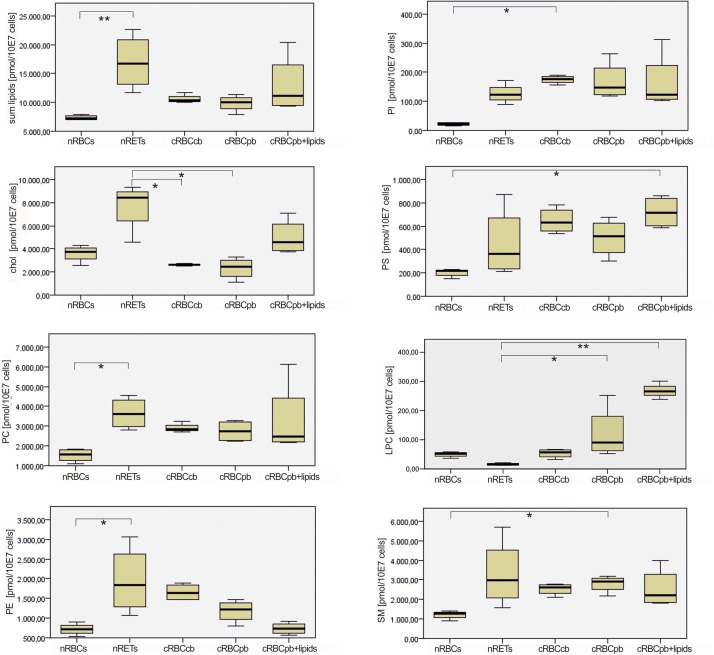
Box and Whisker Blots showing differences in absolute contents of cholesterol and measured phospholipid species between nRBCs, nRETs, cRBCcb, cRBCpb, and cRBCpb+lipids (n = 4, each). Samples were analyzed with Kruskal–Wallis Test for independent samples. Significance values were adjusted with Bonferroni correction (∗p < 0.05; ∗∗p < 0.01).